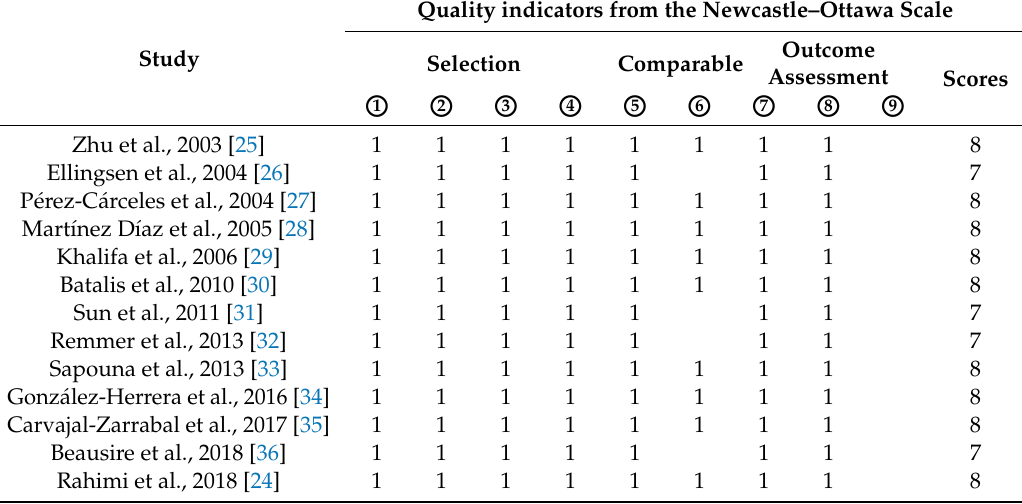
Table 3. Quality assessment of included